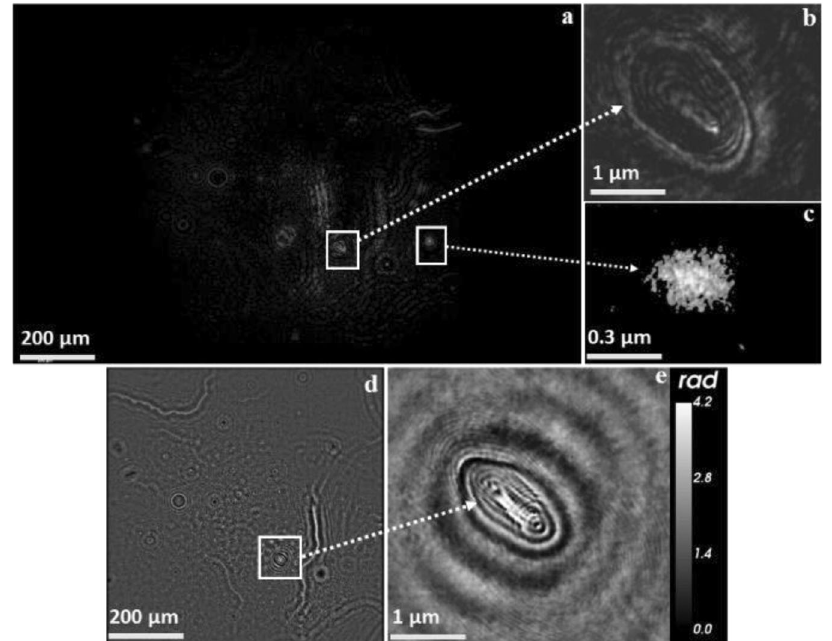
Fig. 8 Hologram reconstruction for ambient air showing different airborne particles ’ sizes, shapes, and morphologies. a Intensity reconstruction of airborne particles. b , c High-resolution intensity images. d Phase reconstruction of image a . e Phase image. The phase of particles through a cross-section were shown in Supplementary Fig. S8a – f. Simultaneously aerosol size distribution obtained from the SMPS and the OPS were shown in Supplementary Fig. S9a,